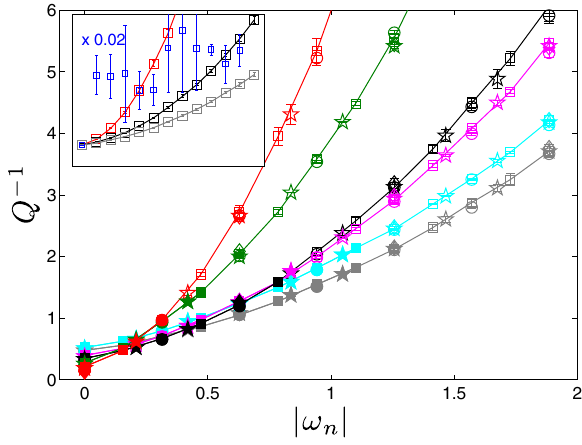
FIG. 14. Frequency dependence of the inverse quadrupolar correlator at h ≈ h for a variety of small momenta in an L ¼ 20 c system at temperatures T ¼ 0 . 025 , 0.033, 0.05, 0.1 (shown as squares, stars, circles, and diamonds, respectively). Different colors represent different values of q , with the same color scale as q j , where < v in Fig. 12. Filled symbols mark frequencies j ω n j F j v is the minimum value of the bare Fermi velocity. The inset F shows the subset of the data with T ¼ 0 . 025 and momenta along the (10) direction shifted by their zero-frequency value, with the same scale as the main figure. The data for q ¼ 0 are scaled down by a factor of 0.02 to appear on the same scale.